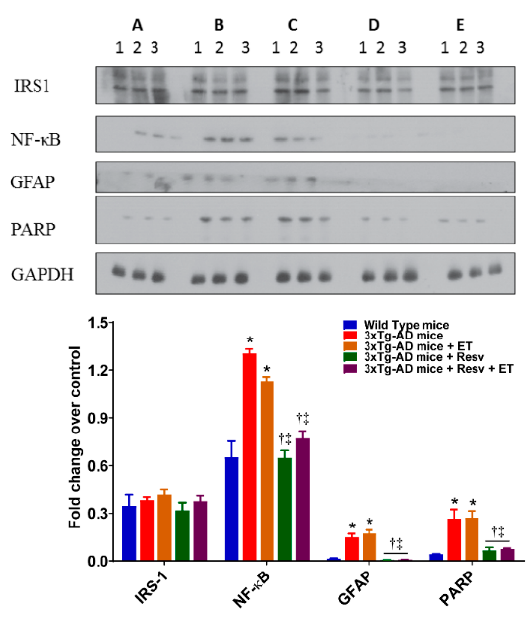
Figure 2. The e ff ects of Resv and exercise training (ET) markers of neuroinflammation. Treating 3xTg-AD mice with Resv or Resv with ET decreases the expression of key inflammatory markers. Corresponding densitometry measurements: A, wild-type (WT) mice; B, 3xTg-AD mice; C, 3xTg-AD mice + ET; D, 3xTg-AD mice + Resv; E, 3xTg-AD mice + Resv + ET. NF- κ B, nuclear factor-kappa B; GFAP, glial fibrillary acidic protein; PARP, poly (ADP-ribose) polymerase; IRS-1,